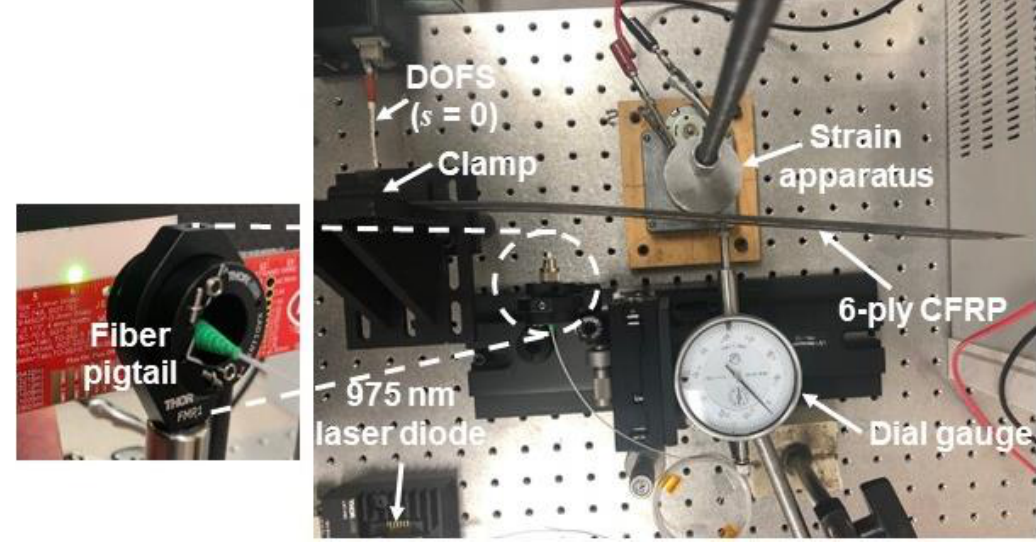
Figure 5. Experimental setup used to apply strain and localized heating to the CFRP specimen. The photo of the end of the fiber pigtail shows measurement of the spot size using a ruler against an IR viewing card.